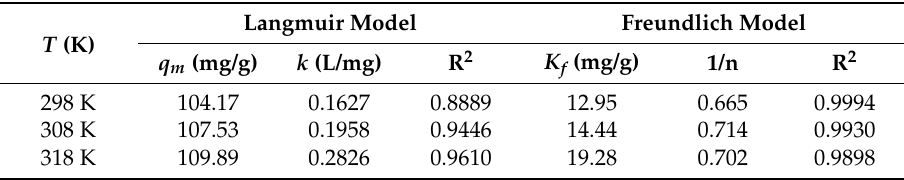
Table 2. Relative parameters of Langmuir and Freundlich model for Cd(II) adsorption on Mn oxide.